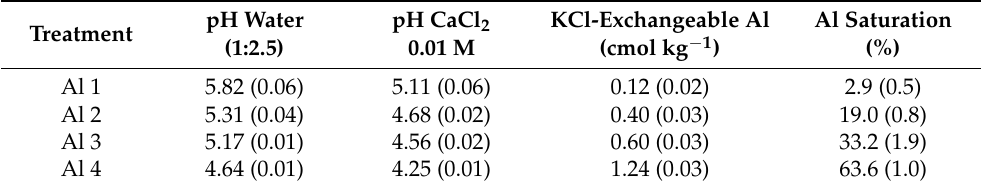
Table 1. Soil chemical characteristics of the treatments. The values are the means, with standard errors in parentheses ( n =